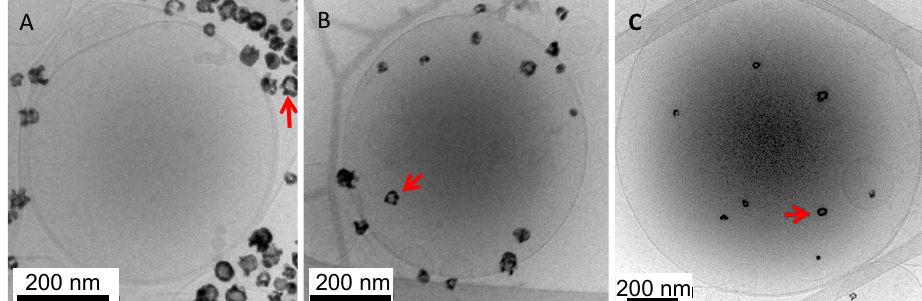
Figure 13. Cryo-TEM images of interdigitated-fusion DPPC liposomes ( A ) mixed with HGN, ( B ) teth- ered to the HGN via a lipid-PEG-thiol linker, or ( C ) encapsulated within the liposome [51,52]. Adapted from [51,52], published by ACS, 2008 and Elsevier, 2009.